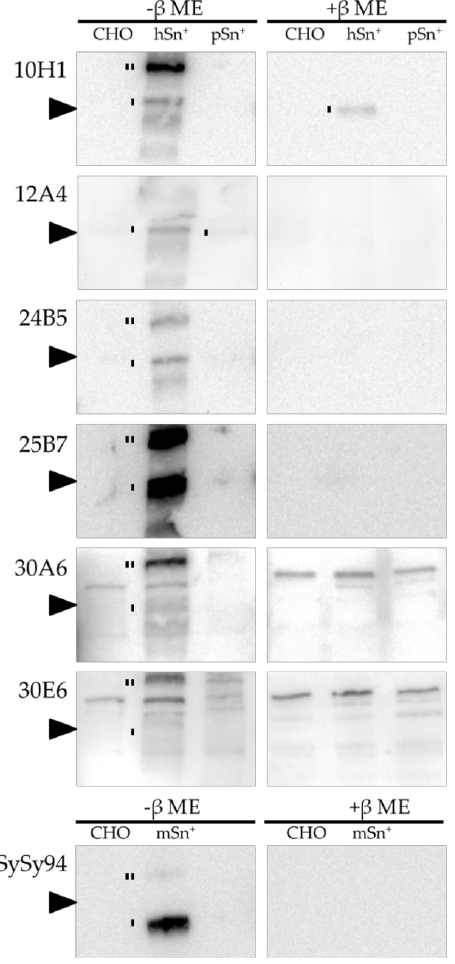
Figure 3. Western blot analysis of the different mAbs. Lysates of CHO, hSn + -CHO, pSn + -CHO, and mSn + -CHO were run under non-reducing (-β mercaptoethanol (ME)) and reducing (+β ME) conditions. The newly developed mAbs were added to the blots followed by an anti-mouse or anti-rat horseradish peroxidase (HRP)-labeled secondary antibody. Sn monomers and dimers are peroxidase (HRP)-labeled secondary antibody. Sn monomers and dimers are indicated with one line indicated with one line and two lines respectively. The arrow indicates 220 kDa. and two lines respectively. The arrow indicates 220